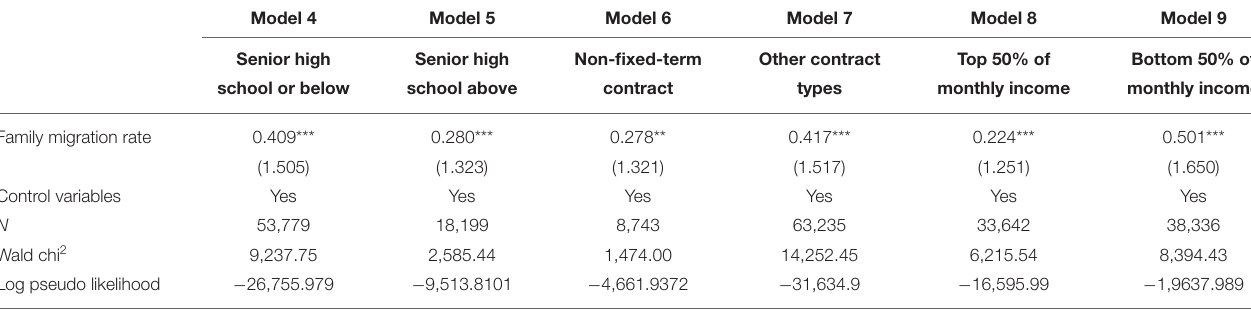
TABLE 7 | Effect of family migration rate on health care participation by education, labor contract types, and income.